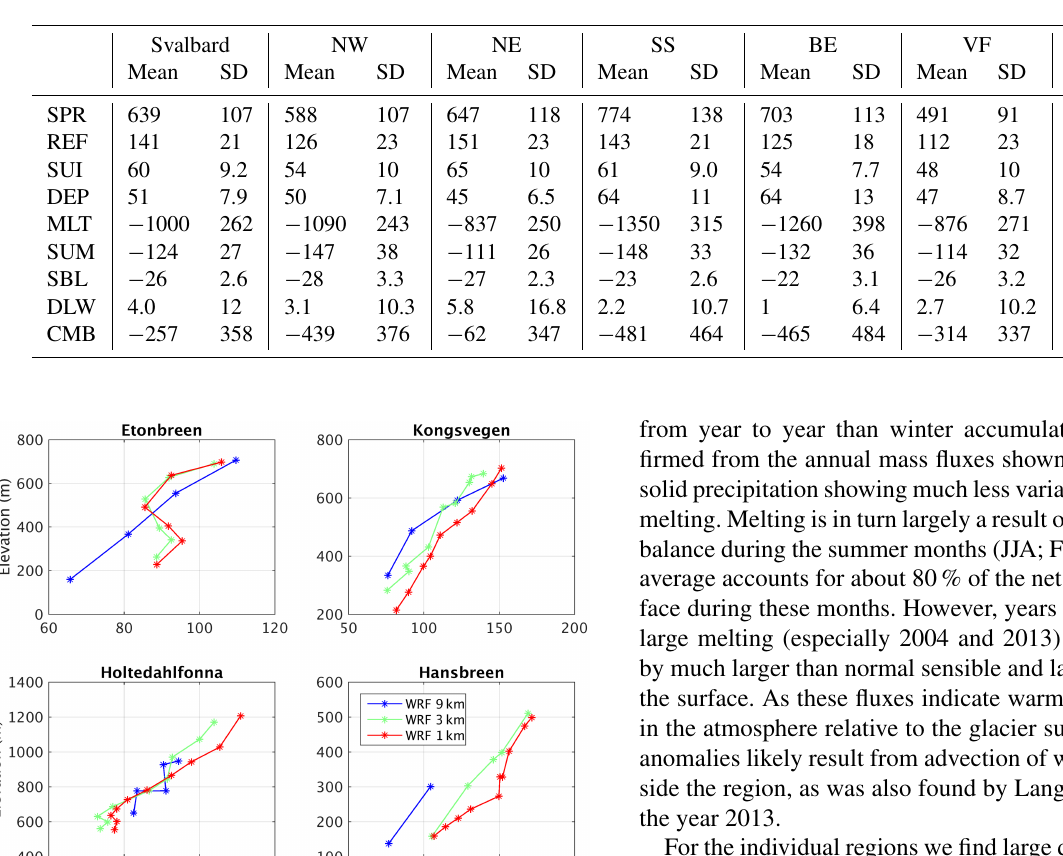
Table 5. Mean annual CMB fluxes (mmw.e.yr − 1 ) and standard deviations (SD) for Svalbard and each subregion in Fig. 1. SPR: solid precipitation; REF: refreeze; SUI: superimposed ice; DEP: deposition; MLT: surface melt; SUM: subsurface melt; SLB: sublimation; DLW: change in snow liquid water.